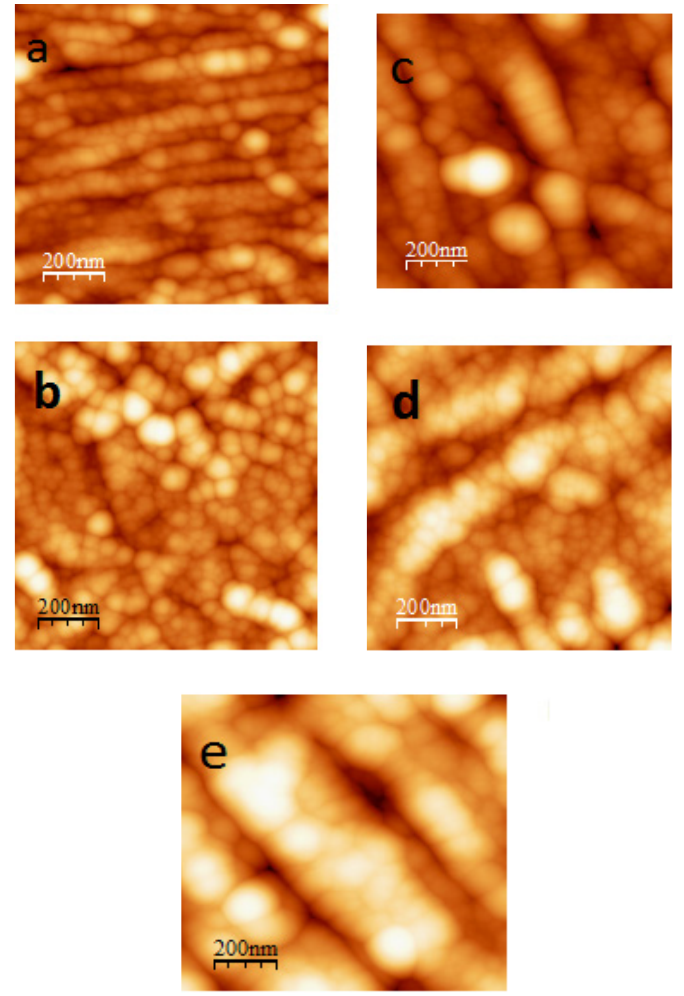
Fig. 5. 2D AFM images of unplanted and nitrogen ion implanted Ta; a) unplanted, b) 1× 10